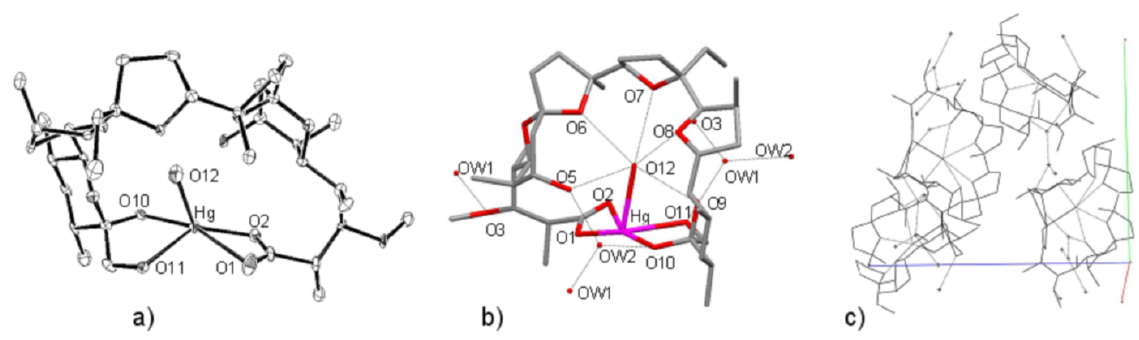
Figure 2. (a) ORTEP drawing of complex 2 at the 50% probability level (Protons and solvent molecules are omitted for clarity); (b) Intramolecular H-bonds (dotted lines) observed in 2 ; (c) Crystal packing of 2 . Table 5. Hydrogen bonds (Å) observed in the structure of complex 2